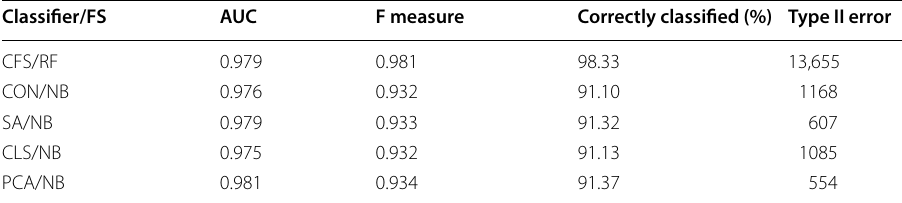
Table 14 Top feature selection method with classifier